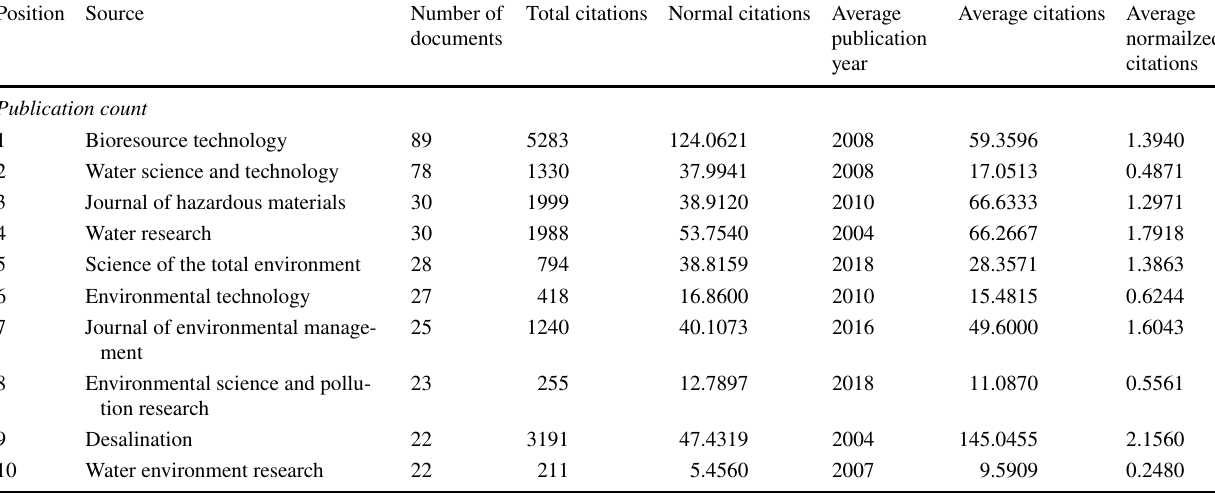
Table 1 List of leading 10 sources of publications in terms of publication